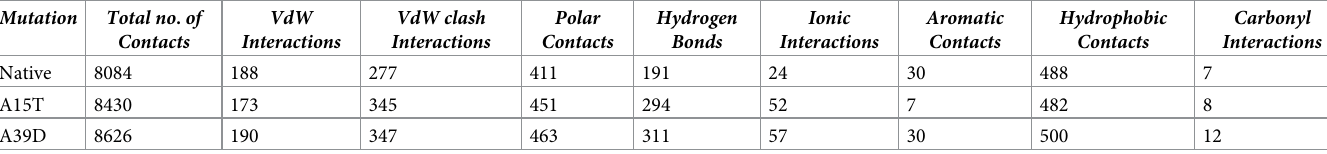
binding affinity of -2.67 kcal/mol and -1.82 kcal/mol, accordingly for SPU and EDO ligands. The A15T mutant model, on the other hand, binds to SPU and EDO ligands differently, with binding affinity value of -1.15 kcal/mol and -2.65 kcal/mol, respectively. When native and mutant proteins were compared, both SPU and EDO binds to various binding pockets; how- ever, examination of the binding pose of SPU and EDO revealed a substantial difference in Table 2. Total number of molecular interactions of native and mutant